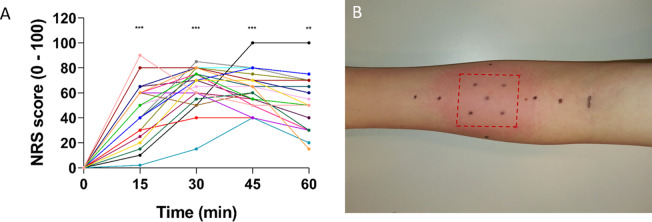
NRS scores during capsaicin treatment and flare response immediately after removal of the patch. (A) NRS scores increased after capsaicin treatment with mean scores peaking 30–45 min after application (n = 21). Individual ratings are represented as dots. Values in time were compared to t = 0 (** ≤ 0.01 and *** ≤ 0.001). (B) Flare response immediately after patch removal in one representative subject. Red dotted lines indicate the area of the patch. Generally, the flare disappeared within 2–3 h after patch removal. NRS, numerical rating scale.